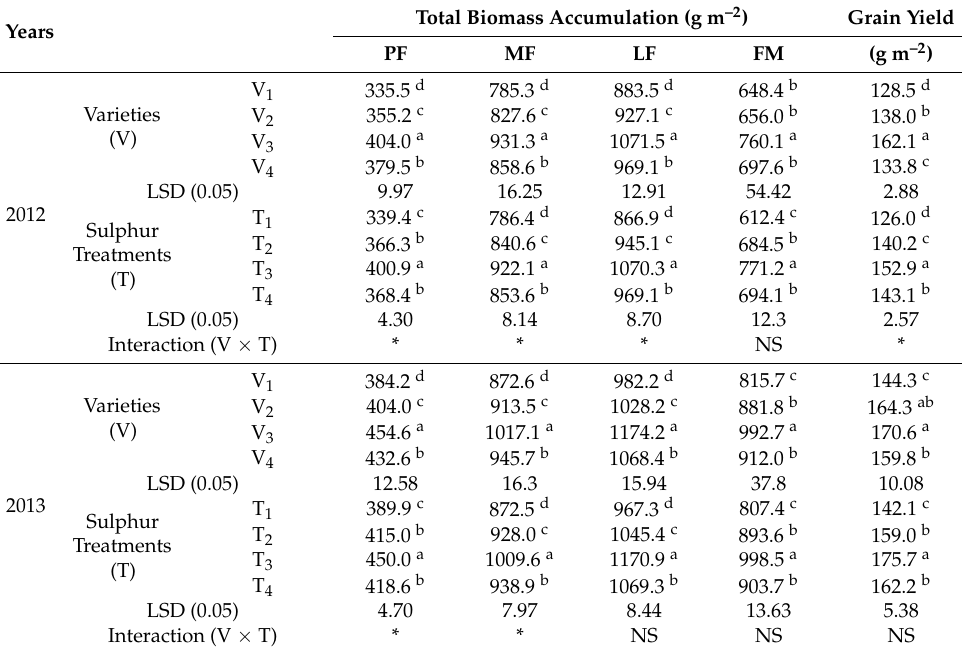
Table 3. Effect of sulphur treatment on total biomass accumulation (TBA) grain yield of sesame